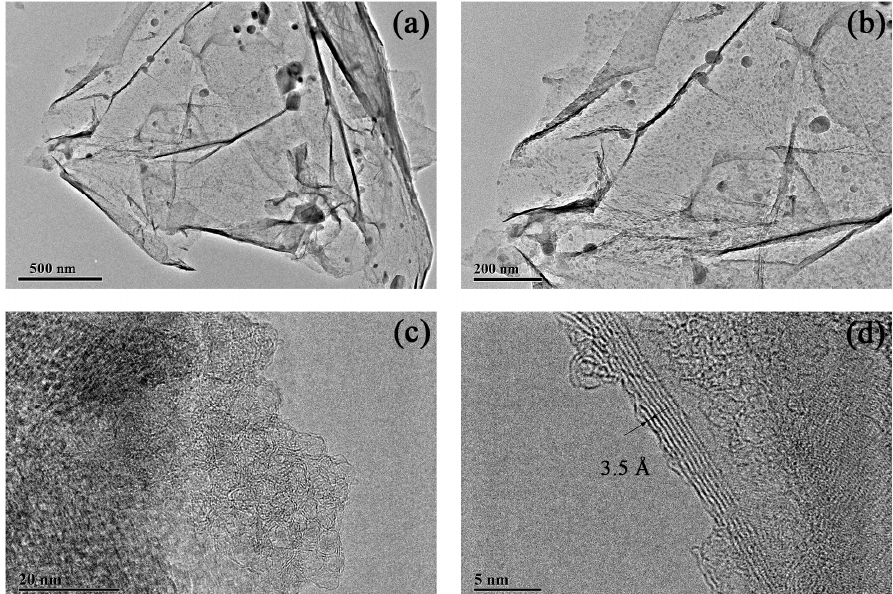
Figure 6. TEM images of multilayered graphene treated with 1.0 M concentration of HCl. ( a ) Thin graphene sheets with occasional folding. ( b ) The composition of multilayered graphene. ( c ) Typical graphene structures occurred on the surface of the sample. ( d ) High-resolution TEM image of multilayered graphene.